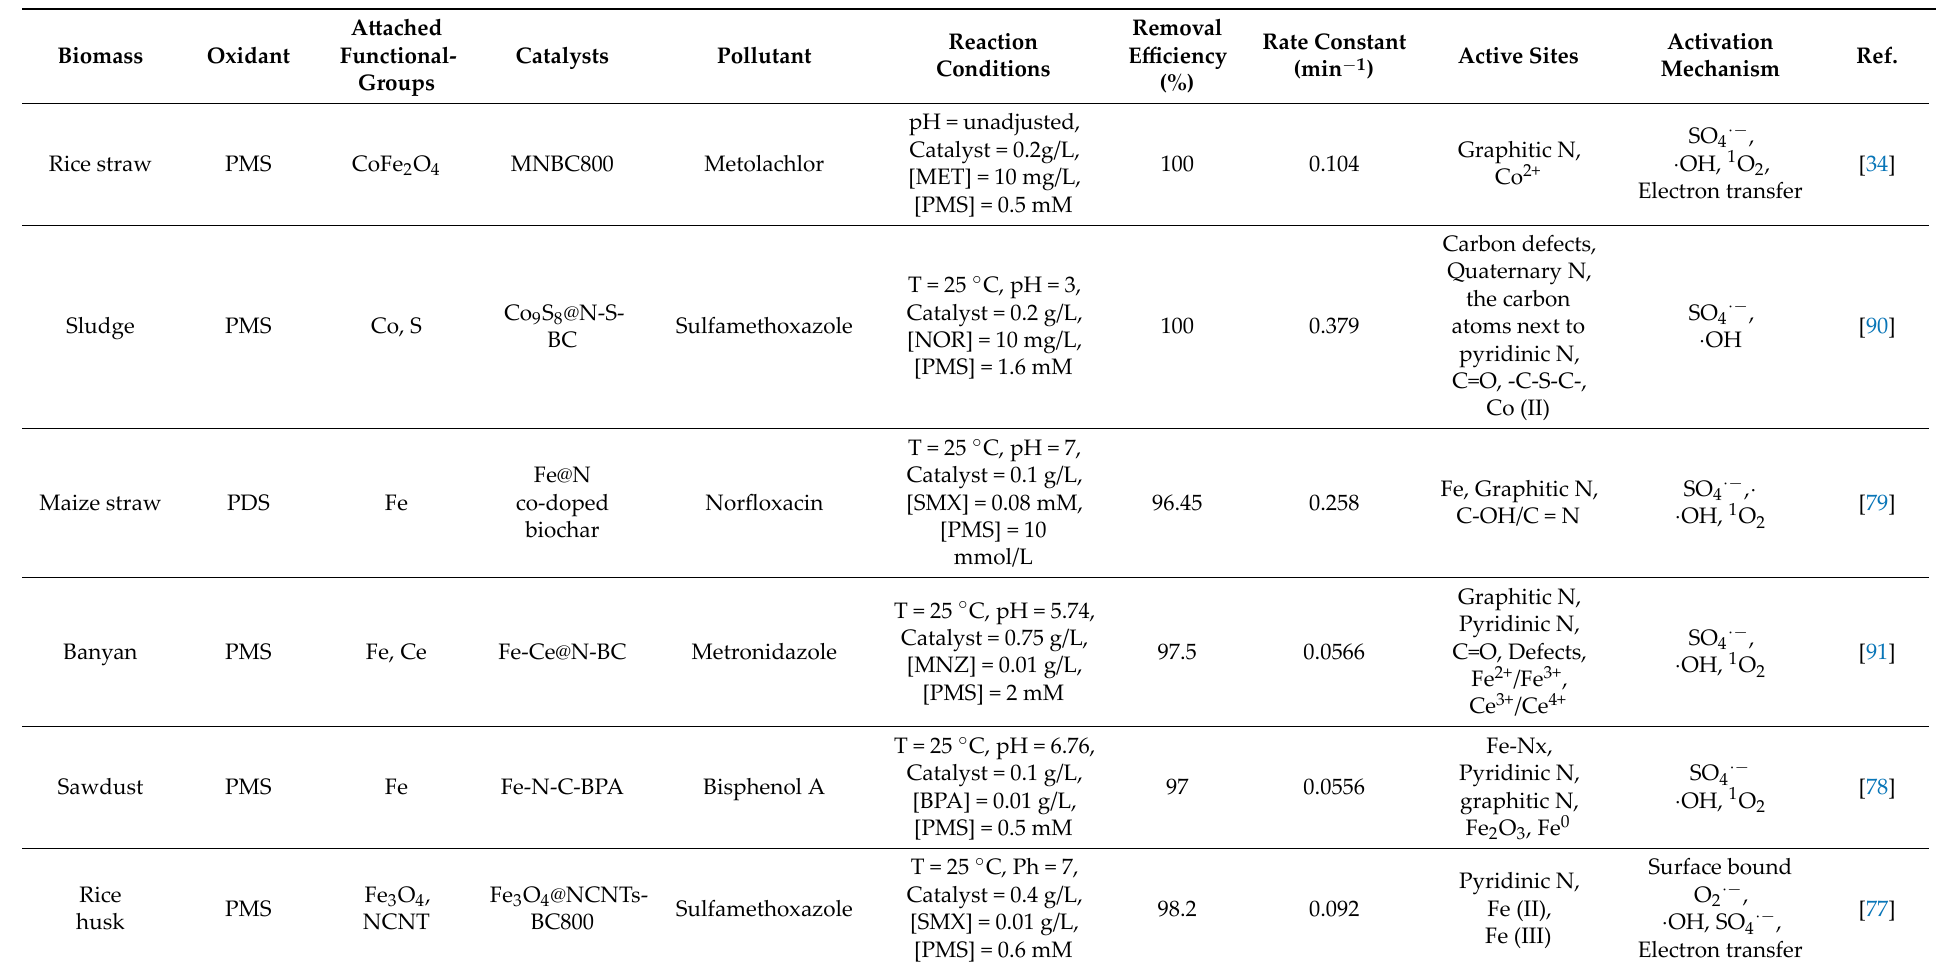
Table 3. List of modified NBC materials as catalysts for